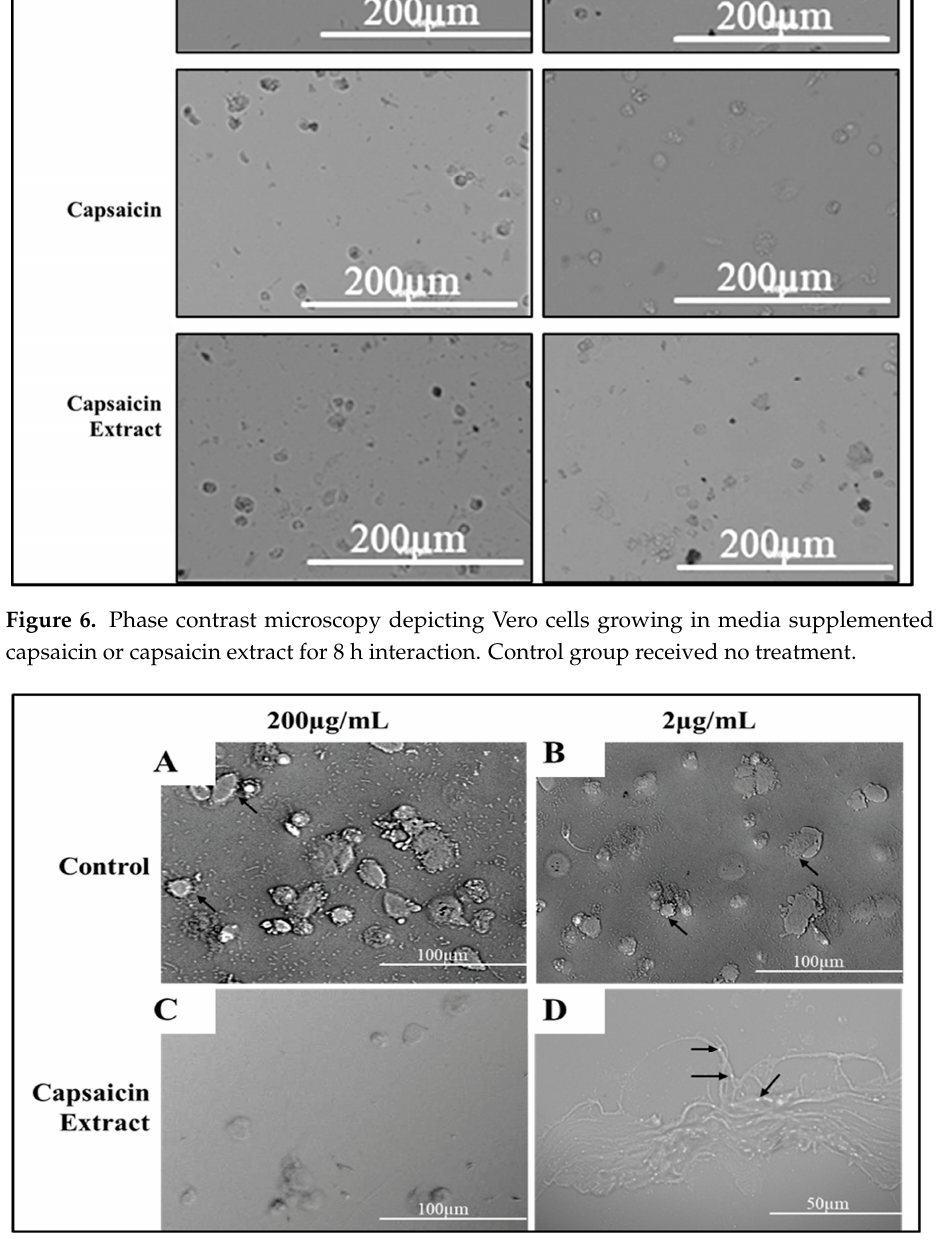
Figure 7. Phase contrast microscopy depicting Vero cells infected with S. typhimurium as control ( A ), and treated with capsaicin extract at 2 or 200 µg/mL ( B , C ), respectively. Experiments were treated for 8 h. Black arrows in ( B ) show attached S. typhimurium to Vero cells, ( C,D ) shows internalized S. and treated with capsaicin extract at 2 or 200 µ g/mL ( B , C ), respectively. Experiments were treated typhimurium in Vero cells. for 8 h. Black arrows in ( B ) show attached S. typhimurium to Vero cells, ( C ) shows internalized S. typhimurium in Vero cells and ( D ) shows bacteria attached to Vero cell at higher magnification (50 µ m) as indicated with black